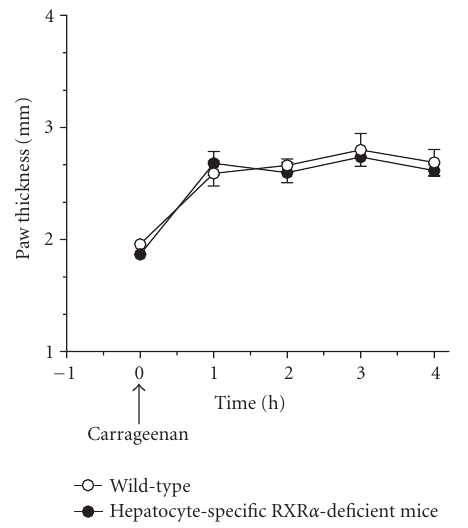
Figure 1: Carrageenan-induced paw edema in hepatocyte-specific RXR α -deficient mice. Wild-type and hepatocyte-specific RXR α - deficient mice were treated with 30 μ L of 1% carrageenan in nor- mal saline subcutaneously into the midplantar region of the right hindpaw. Carrageenan-induced edema, reflected as an increase in dorsal-to-ventral paw thickness, was measured with a microcaliper. Values represent mean ± SEM. n = 8 mice per group.